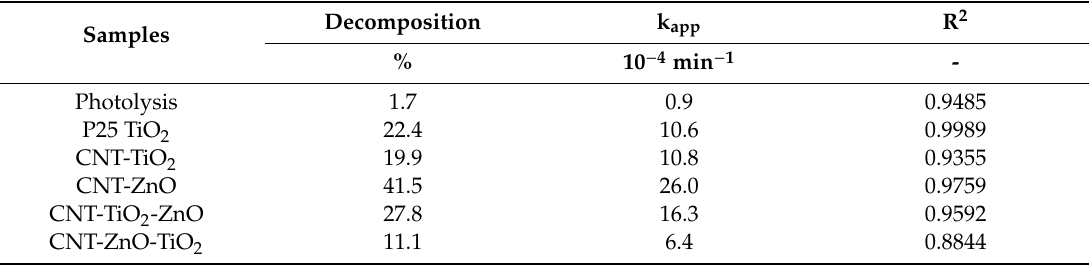
Figure 6. Photocatalytic activities of the samples. Table 5. Results of the photocatalytic